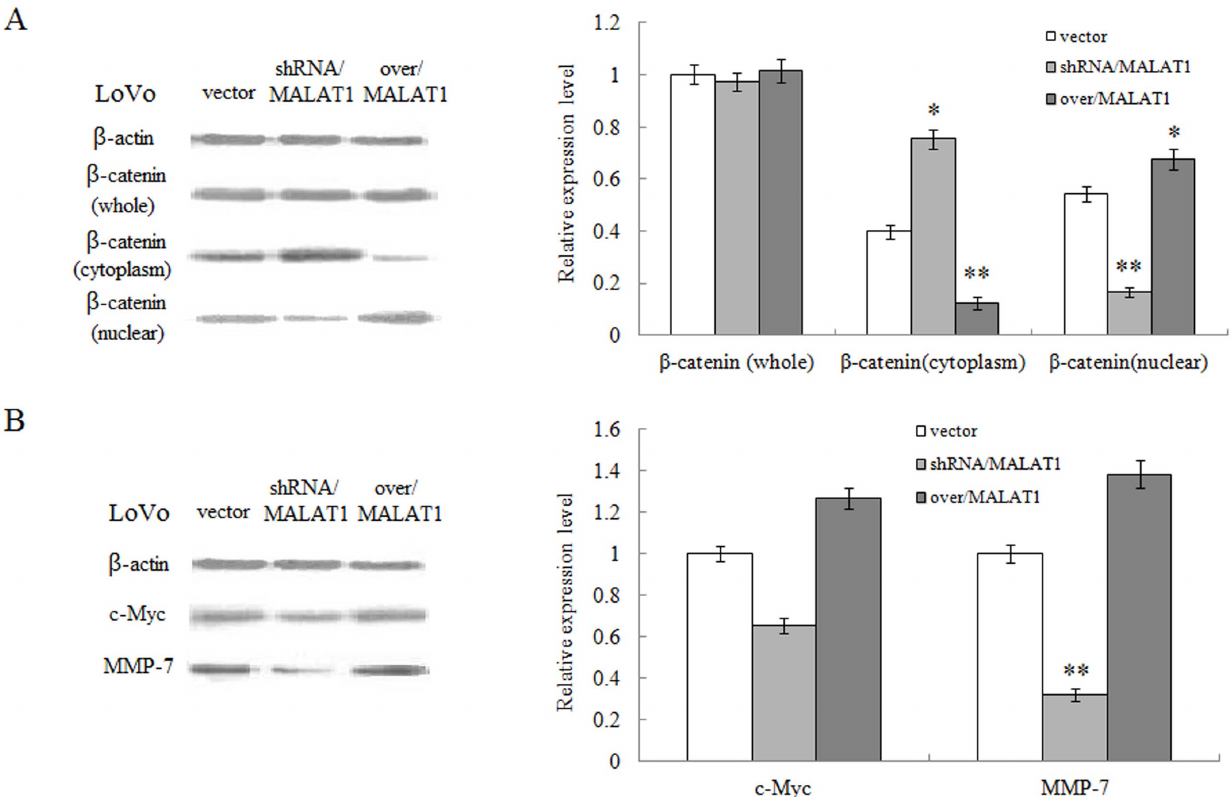
Figure 5. MALAT1 increases the nuclear localization of b -catenin and levels of its downstream proteins in LoVo cells. (A): Whole or cell extracts of different cellular compartments from LoVo cells expressing MALAT1-shRNA, MALAT1-overexpression, empty vector were probed for b - catenin and the protein levels were quantified. * p , 0.05 or ** p , 0.01, compared with vector control. (B): Whole or cell extracts of different cellular compartments from LoVo cells expressing MALAT1-shRNA, MALAT1-overexpressed, empty vector were probed for c-Myc, MMP-7 and the protein levels were quantified. * p , 0.05 or ** p , 0.01, compared with vector control.